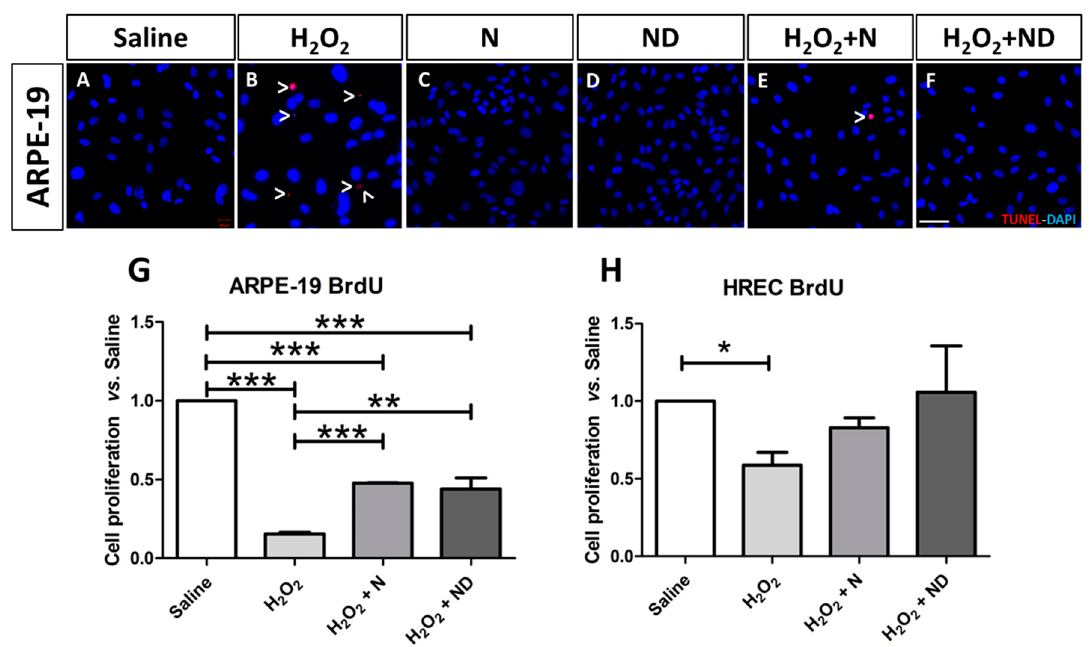
Figure 2. Late apoptosis assessed in ARPE-19 cells by TUNEL labelling and imaged under a confocal microscope. Applica- tion of N and ND treatments (62.34 µ g/mL) to the media ( C , D ) showed similar results to saline ( A ). Addition of H 2 O 2 (2 h; 600 µ M) to induce oxidative stress increased TUNEL-positive-stained ARPE-19 cells ( B ; red), while TUNEL labelling was absent by application of N and ND treatments (62.34 µ g/mL each) during the last hour of the induction ( E , F ). Nuclei were labelled with DAPI (blue). Scale bar: 50 µ m. Cell proliferation assay was performed in both ARPE-19 and HREC cells ( G , H ), n = 3. BrdU expression levels were significantly reduced in both cell lines following oxidative stress-induced conditions by 1000 µ M H 2 O 2 for 2h. This effect was significantly recovered in ARPE-19 cells by application of N ( p < 0.001) and ND ( p < 0.01) treatments (62.34 µ g/mL each) during the last hour of the induction, while a strong tendency towards significance was observed in HREC cells (* p < 0.05, ** p < 0.001, *** p < 0.001).